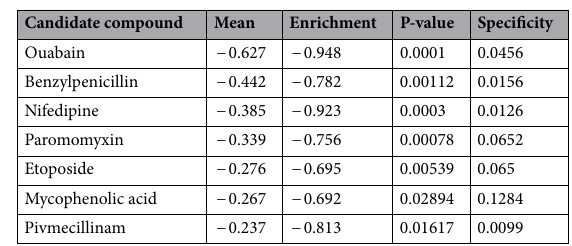
Table 1. The list of candidate compounds for treating cabazitaxel-resistant prostate cancer.